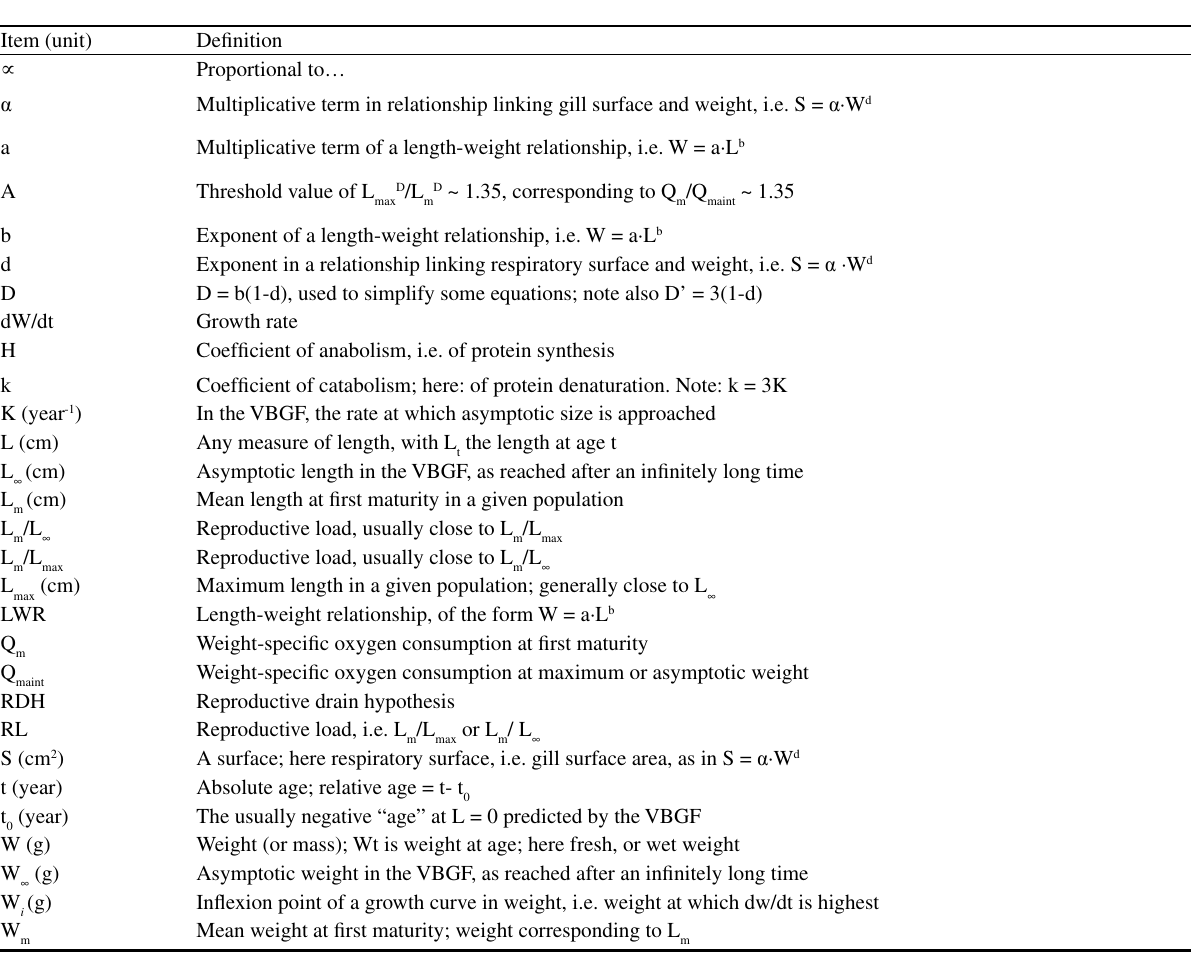
Table 1. – Definitions of the parameters (and their units), symbols and acronyms used in this